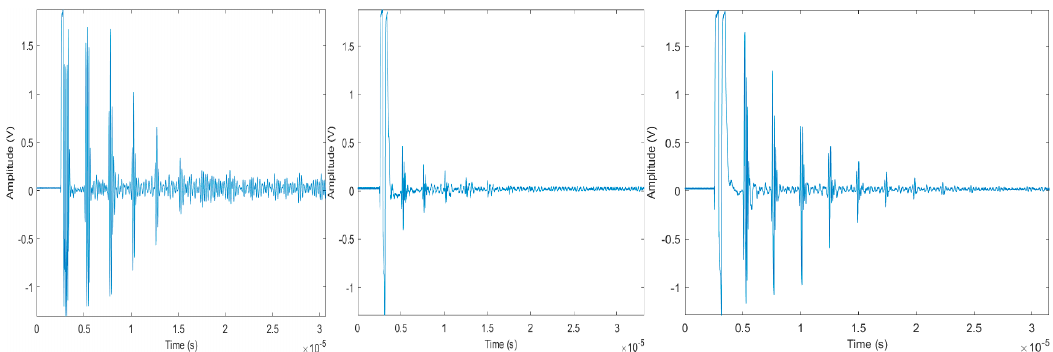
Figure 13. A-scan pulse-echo measurements of Bi 4 Ti 3 O 12 (left), LiNbO 3 (center), and organic Bi 4 Ti 3 O 12 (right) thick-film transducers deposited on steel cylinder (7 mm) at 40 dB gain, film thickness ~200 micron, and frequency ~1.5 MHz [7].